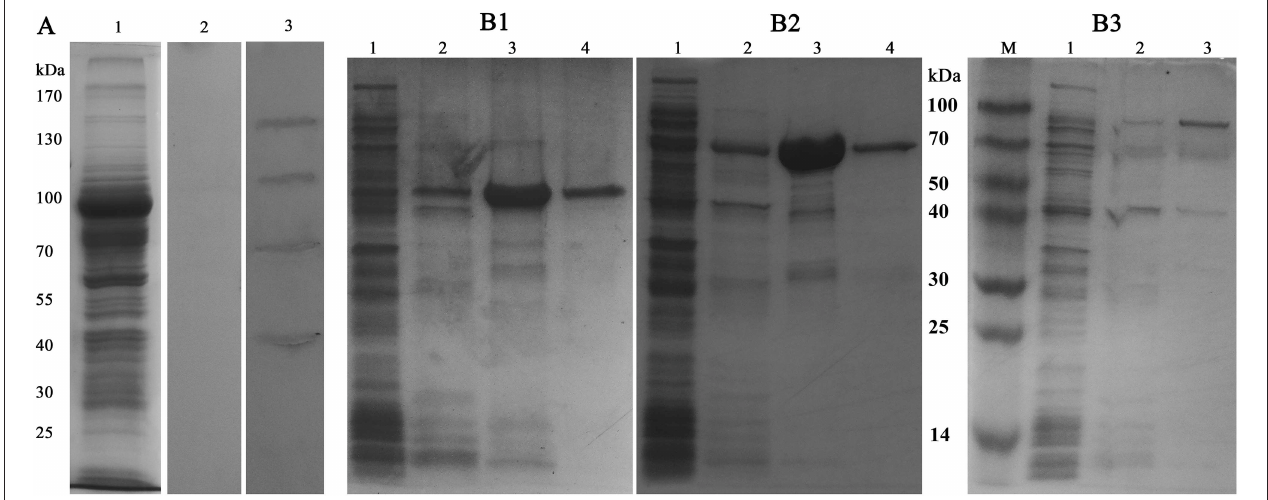
FIGURE 3 | Identification and expression of ligand proteins for MrLGBP. (A) Far western blotting was used to identify proteins on S. eriocheiris that could bind to MrLGBP. S. eriocheiris total proteins were analyzed by SDS-PAGE (Lane 1). S. eriocheiris ligand proteins were detected by far western blotting (Lane 2 and 3). Line 1, S. eriocheiris proteins (20 µ g). Line 2, GST tag as a control blot. Line 3, identification of ligand proteins for MrLGBP. (B1–B3) ligand proteins (SeEnolase, TK, and ALDH) recombinant expression in E. coli analyzed by SDS-PAGE. Lane 1, flow-through component; lane 2, eluate with 50mM imidazole; lane 3, eluate with 100mM imidazole; lane 4, eluate with 500mM imidazole.